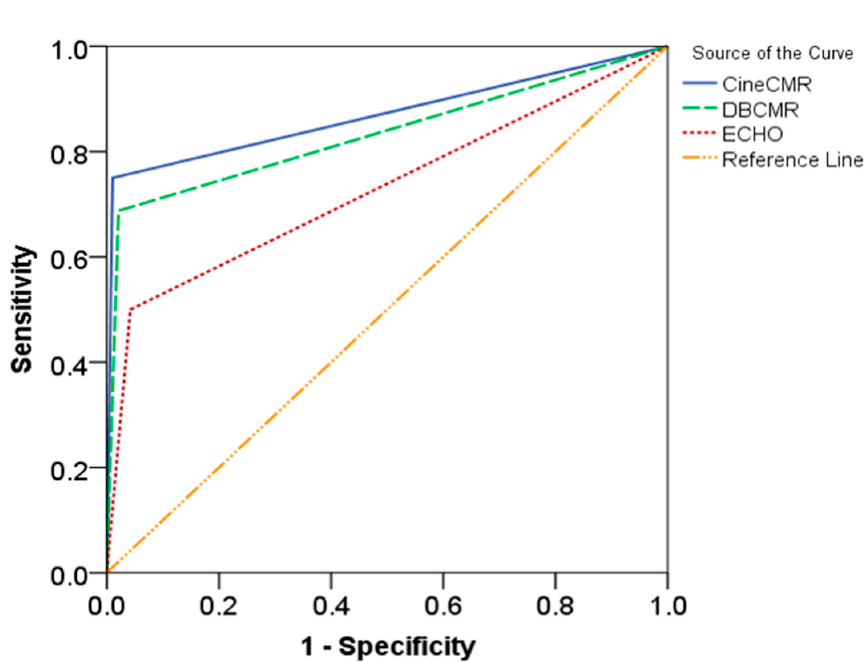
Figure 4. The receiver operating characteristic (ROC) curves of the left ventricular thrombi diagnostic performance from cine-CMR (solid blue line), DB-CMR (dashed green line), and echocardiography (dotted red line ). Table 3. Diagnostic performance of different techniques for detecting LV thrombus .